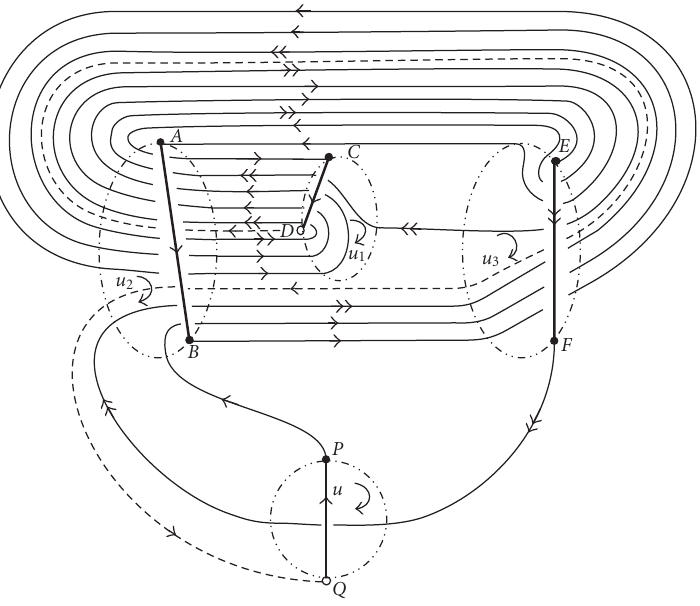
Figure 3.2. Determining the branch set of a representation of M 3 as 2-fold branched